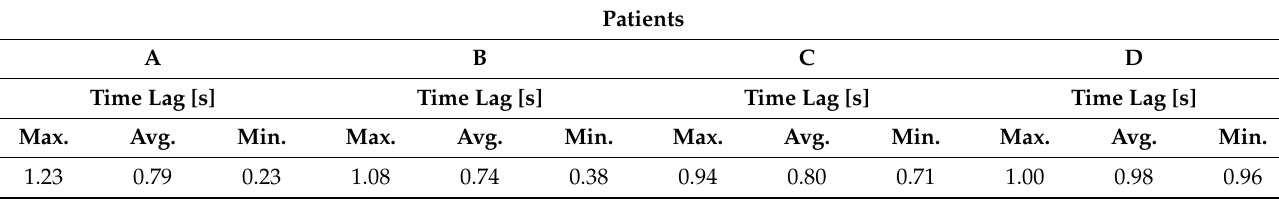
Table 10. Results of time lags in the preliminary outdoor experiment.